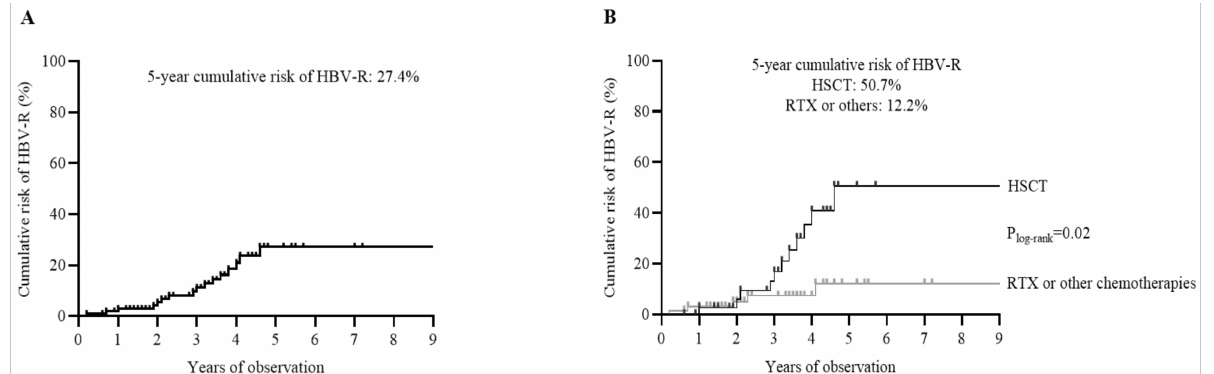
Figure 1. Survival analysis by competing risk estimates of the cumulative odds of HBV reactivation. The graph plots report the cumulative risk for the occurrence of HBV-reactivation in overall popula- tion (N = 107) ( A ) and in patients stratified according to HSCT (N = 40) versus RTX (N = 42) and/or other chemotherapies (N = 25) ( B ). The cumulative risk was calculated by Kaplan Meier. Statistically significant difference was calculated by log-rank